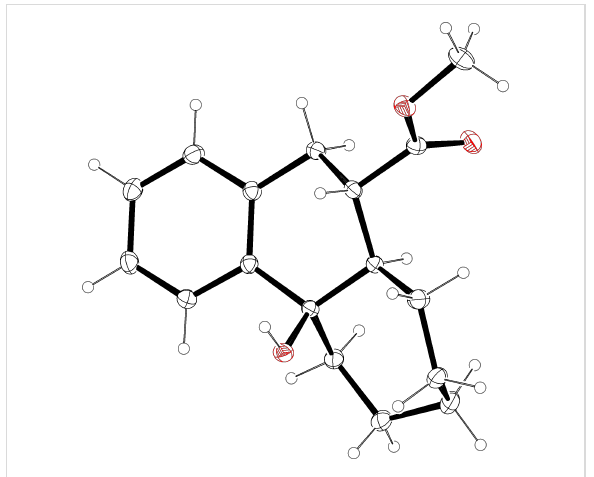
Figure 4: Molecular structure (ORTEP [14]) of compound 15b (ther- mal ellipsoids at 50% probability).